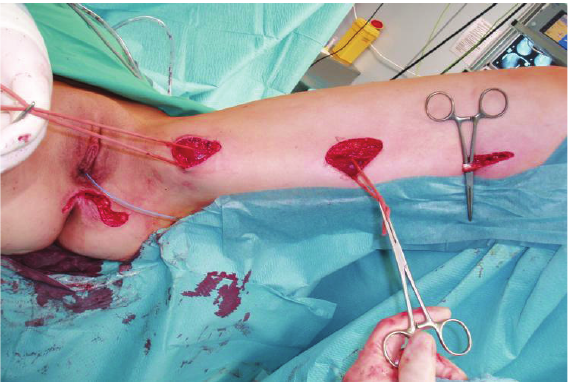
Figure 1: The preparation of the left gracilis muscle flap after perineal incision and closure of the PVF.